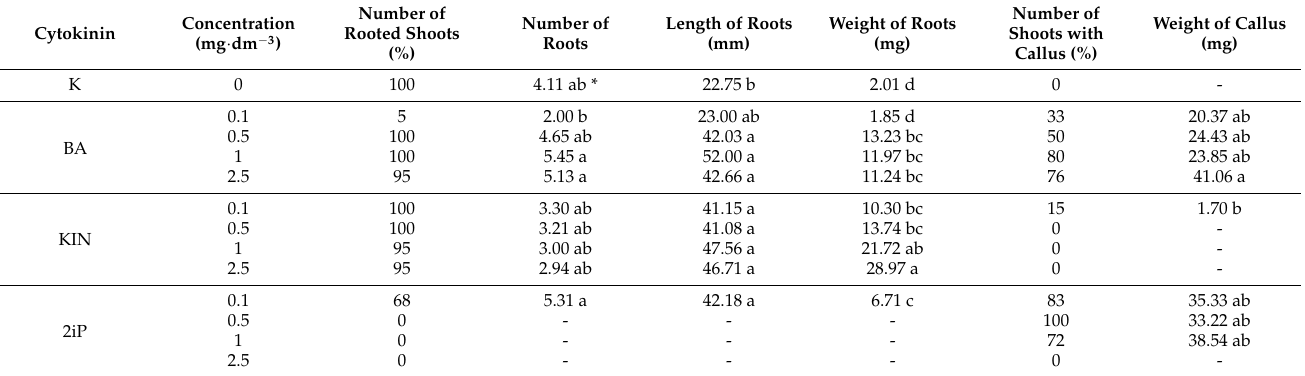
Table 5. Rooting of S. myrtilloides shoots in tissue culture depending on cytokinins added to the